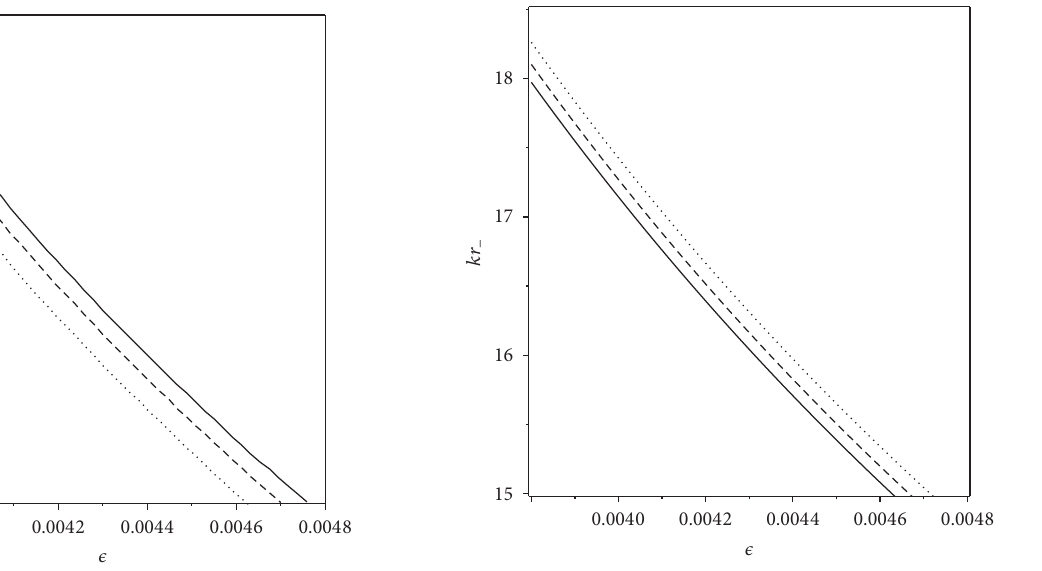
Figure 2: The variation of 𝑘𝑟 − defined by (15) and (19) versus the parameter 𝜖 . The values of the parameters are V 𝑠 = 1 and V 𝑝 = 1.2 . The solid curve corresponds to limit of infinite coupling ( 𝑡 = 𝑞 = 0.0 ). For the dashed curve the values of these parameters are 𝑡 = 𝑞 = 0.1 and for the dotted curve are 𝑡 = 𝑞 = 0.2